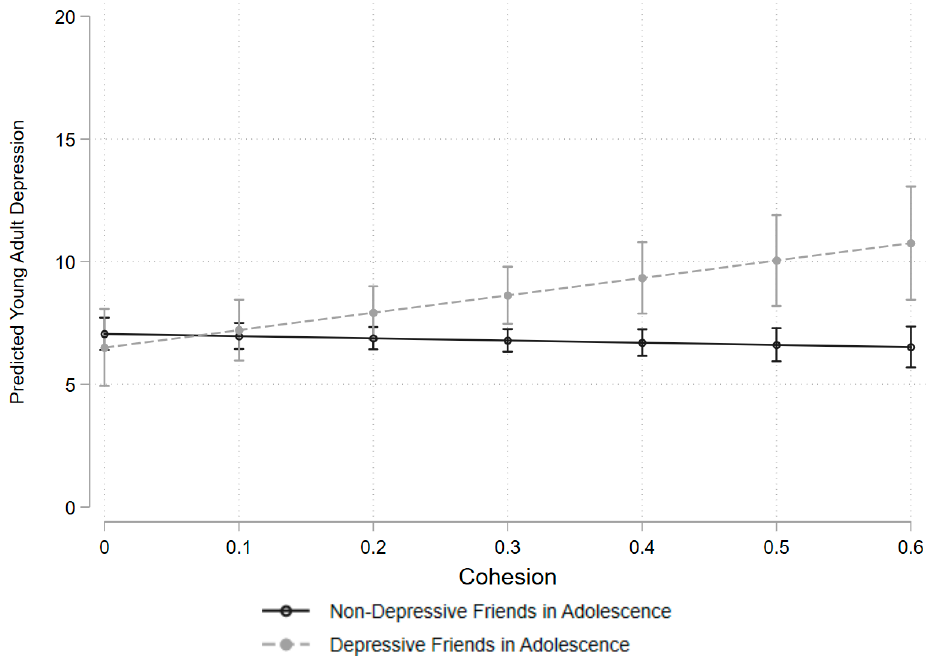
Figure 2. Predicted probability of young adulthood depressive symptoms on adolescent cohesion by high school friends’ depressive symptoms a .